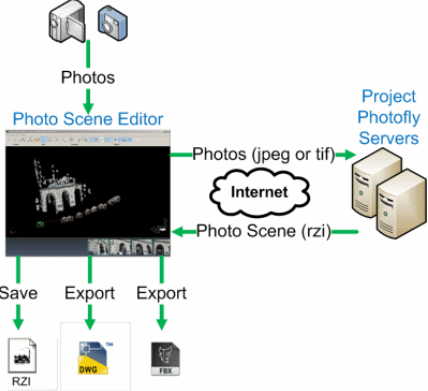
Figure 1. Project Photofly Pipeline